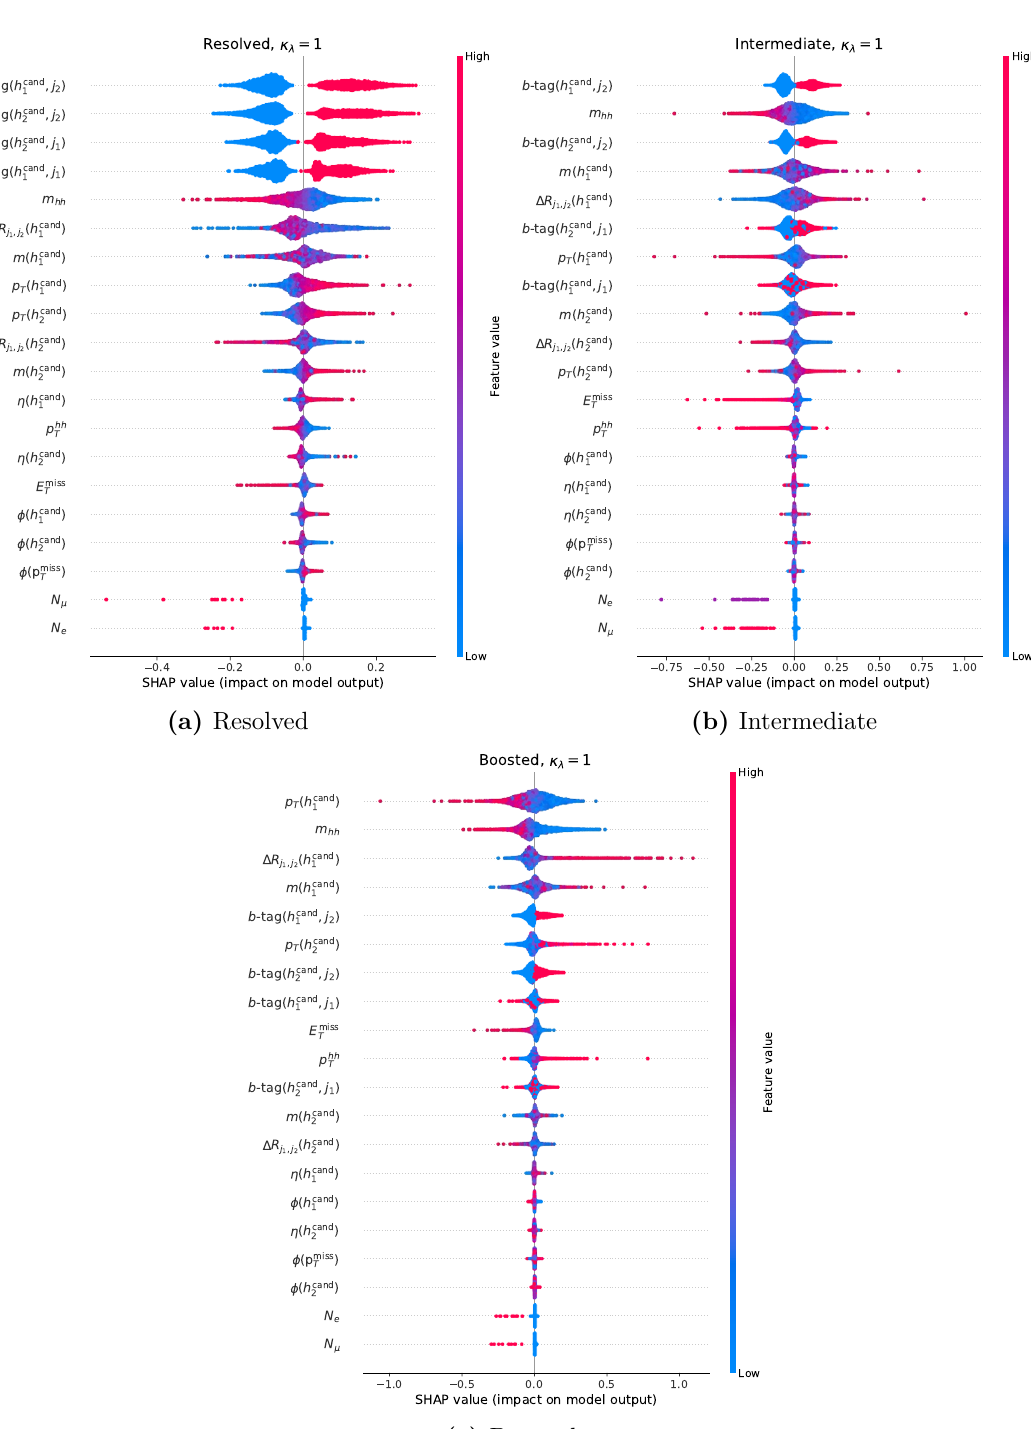
Figure 21. SHAP value plots representing the ranked variable (feature) importance for the DNN trained on κ λ = 1 signals for the (a) resolved, (b) intermediate and (c) boosted categories. The DNN models are ranked by their average absolute SHAP value, which is plotted on the x -axis. The colour scale indicates the value of the feature on the specific event for which the SHAP value is